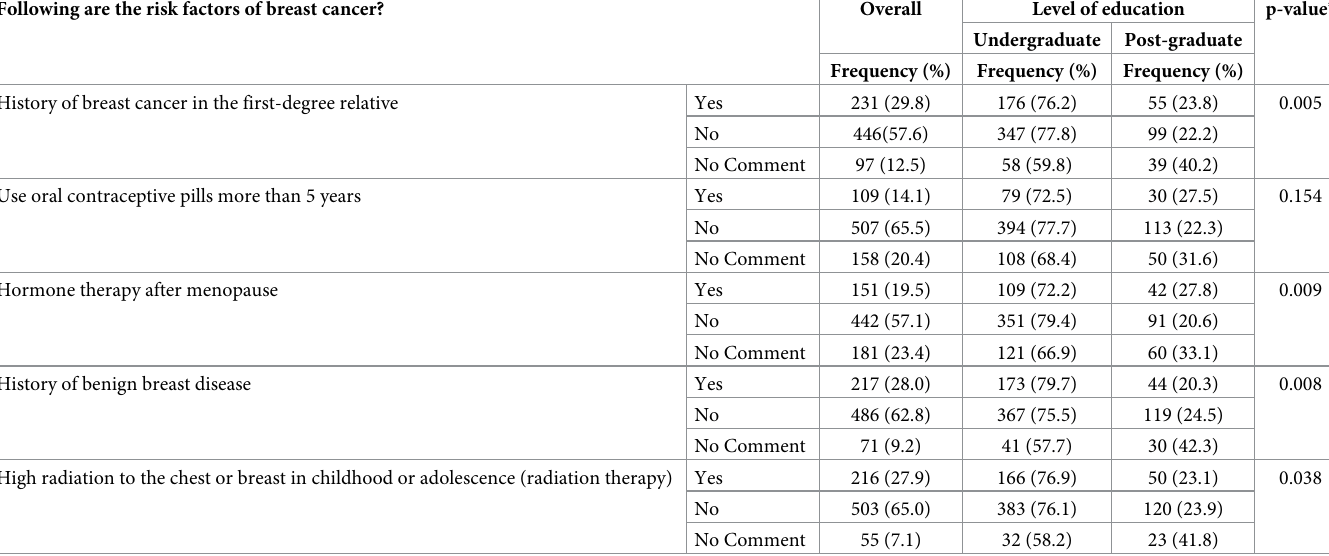
Table 2. Participant’s knowledge of breast cancer’s risk factors regarding the history of breast cancer and benign disease, exposure to radiations, and use of medication. Following are the risk factors of breast